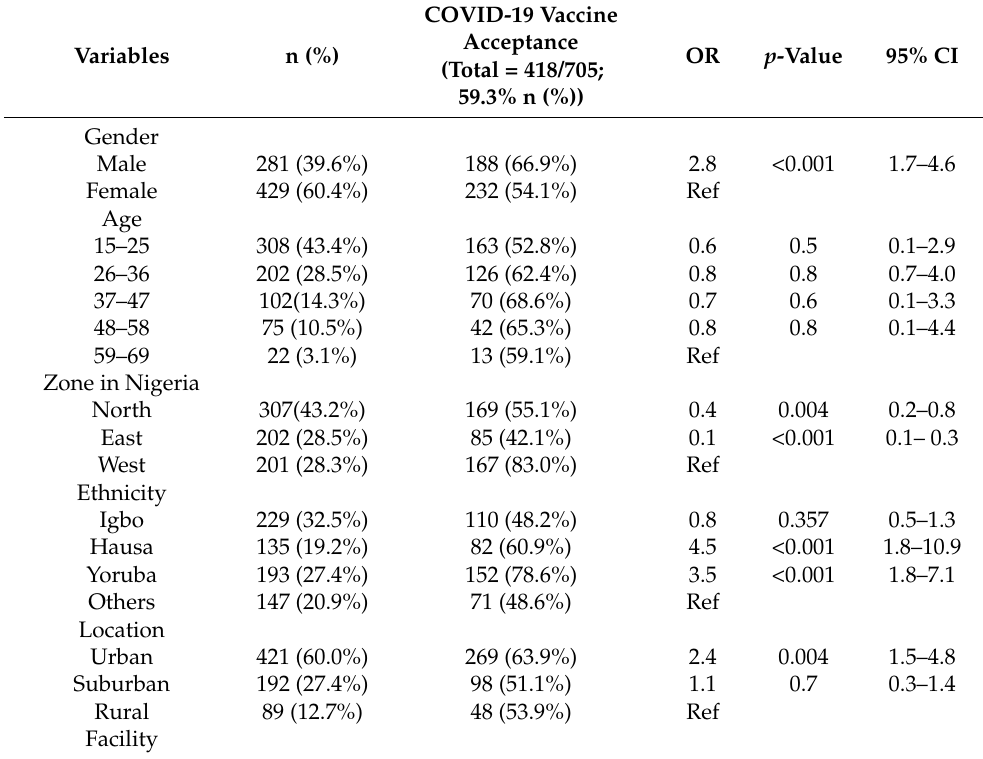
Table 1. Demographic characteristics and multinomial logistic regression for COVID-19 vaccine acceptance among HCWs in